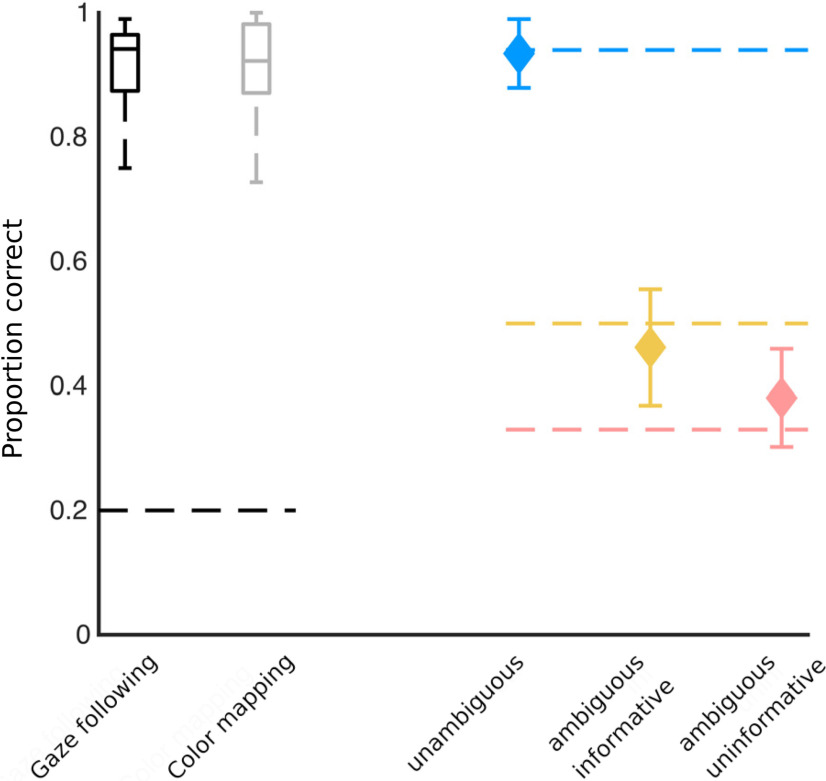
Behavioral performance. Left, Boxplots (black and gray) showing the percentage of correct response in the localizer paradigm (dashed line depicts chance level performance, see Extended Data Fig. 2-1 for a description of the localizer paradigm). Right, Plots of correct responses in the contextual gaze following paradigm (weighted mean performance and weighted SD, dashed lines depict expected performance; blue: unambiguous, yellow: ambiguous-informative, salmon: ambiguous-uninformative).